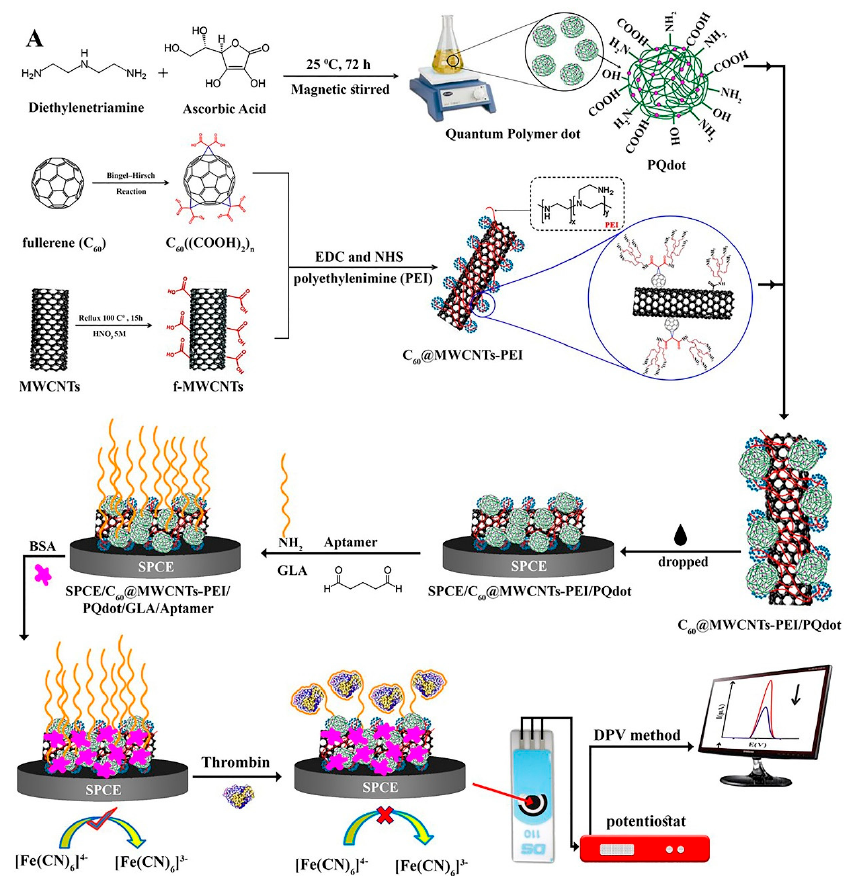
Figure 3. Multi-walled carbon nanotubes and fullerene-based electrochemical aptasensor fabrica- tion for TB detection using the DPV method, and C60/MWCNTsPEI/PQdot